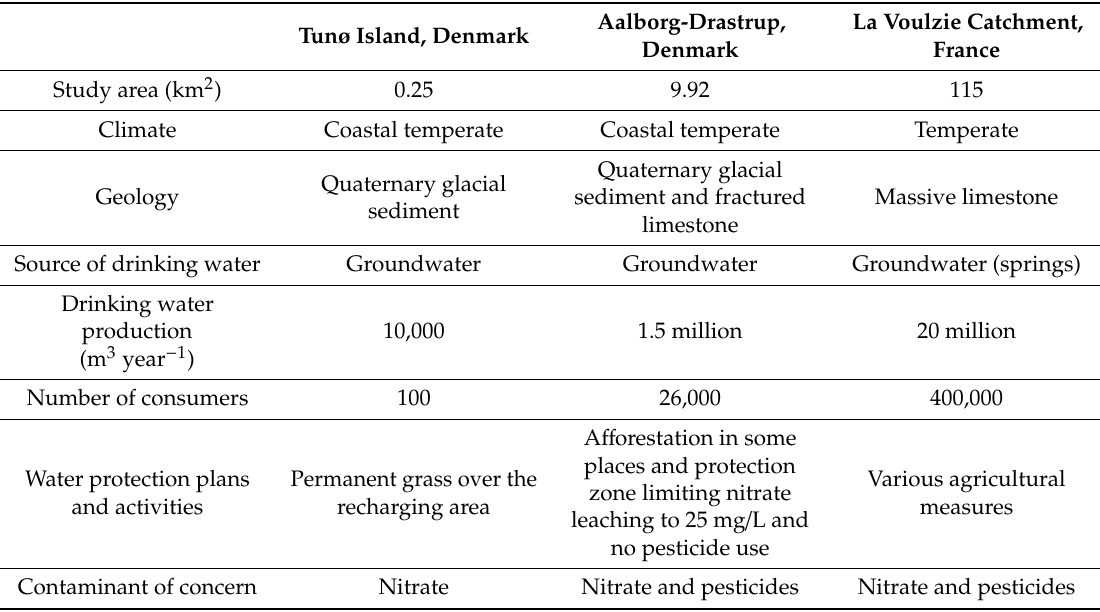
Table 1. Overview of the basic characteristics of the case study